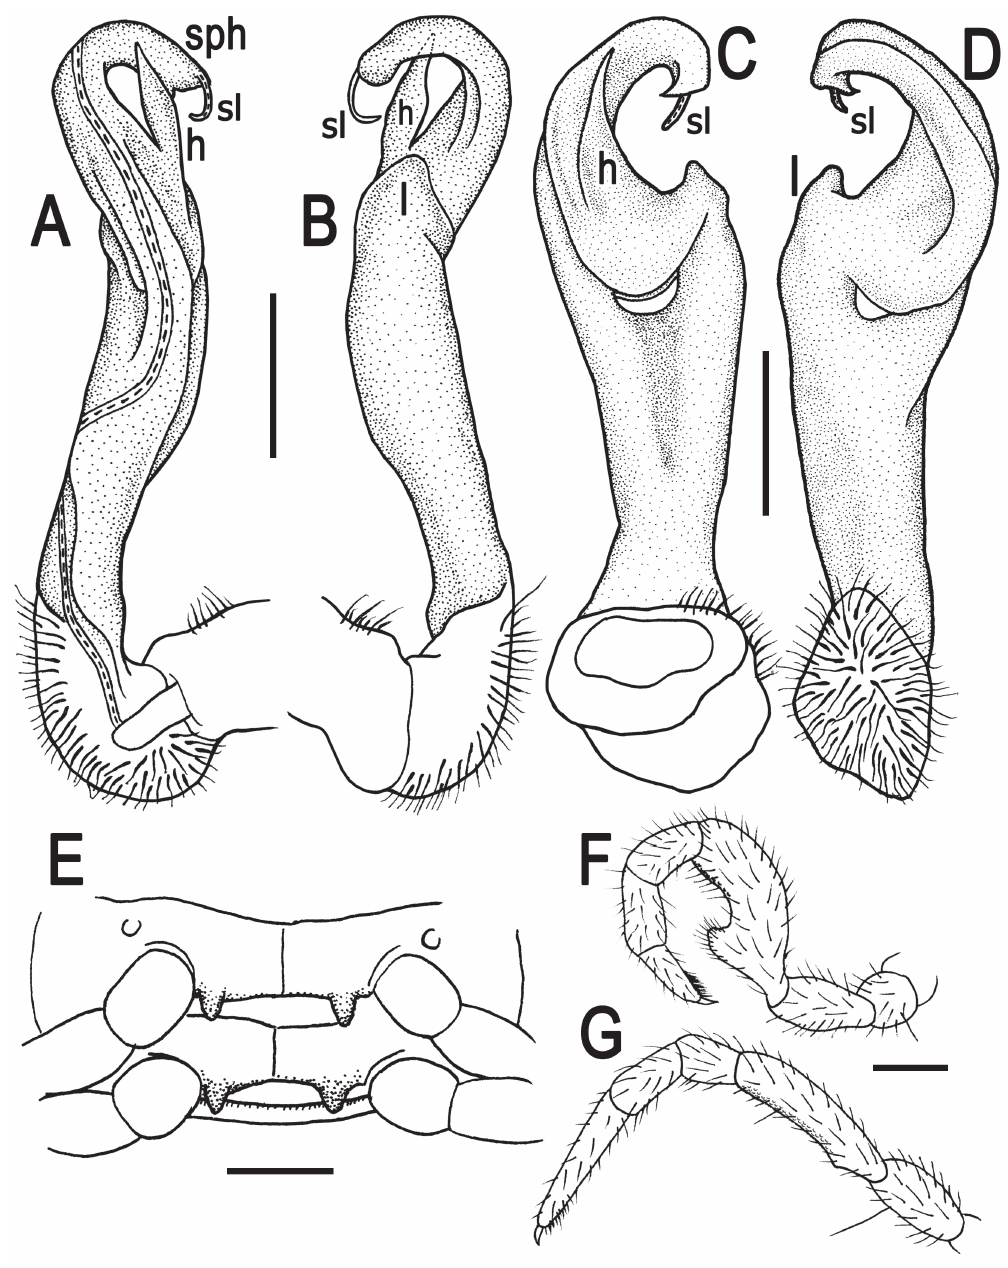
Fig. 2. Tylopus flavolineatus sp. nov., holotype, ♂, left gonopod. A–D . Mesal, lateral, caudal and suboral views, respectively. E . Sterna of segment 10. F . Leg 6. G . Leg 10. Scale bars = 0.5 mm. abbreviations are explained in the